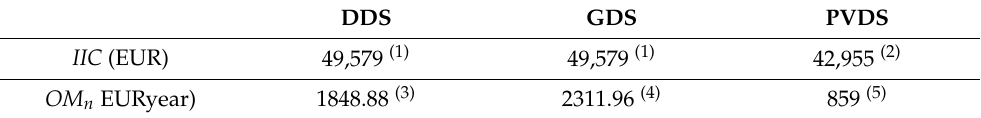
Table 4. Initial investment cost ( IIC ) and annual operation and maintenance cost ( OM n ) considered for the diesel-powered drying system (DDS), grid-powered drying system (GDS), and photovoltaic drying system (PVDS). All the costs include a value-added tax or VAT of 21% for